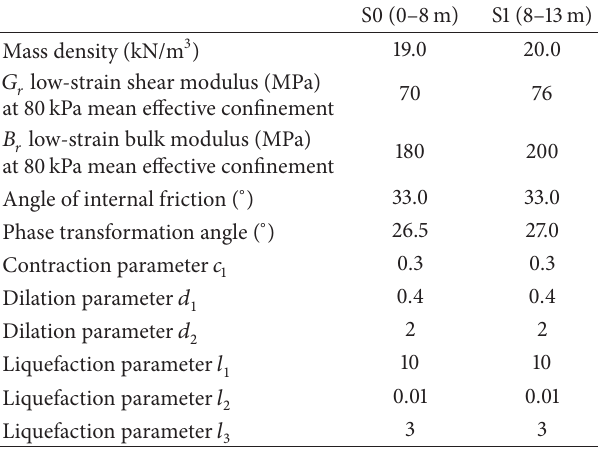
Table 2: Characteristics adopted in the study for S0 and S1 strata.